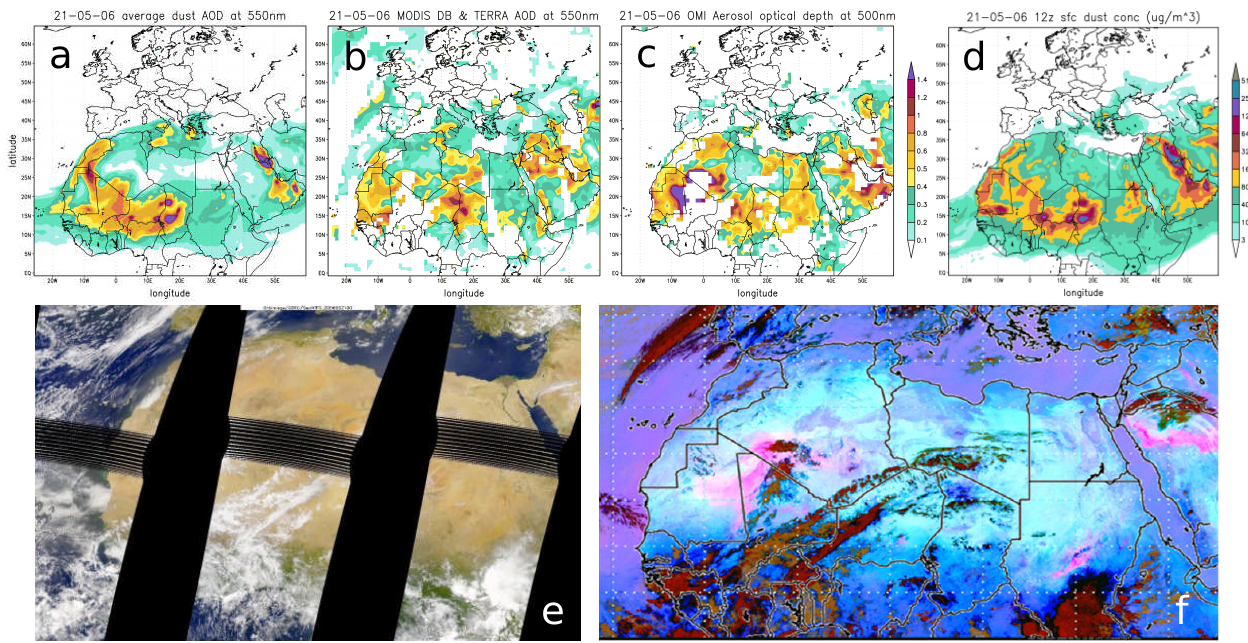
Fig. 7. The same as in Fig. 2, but for 21 May